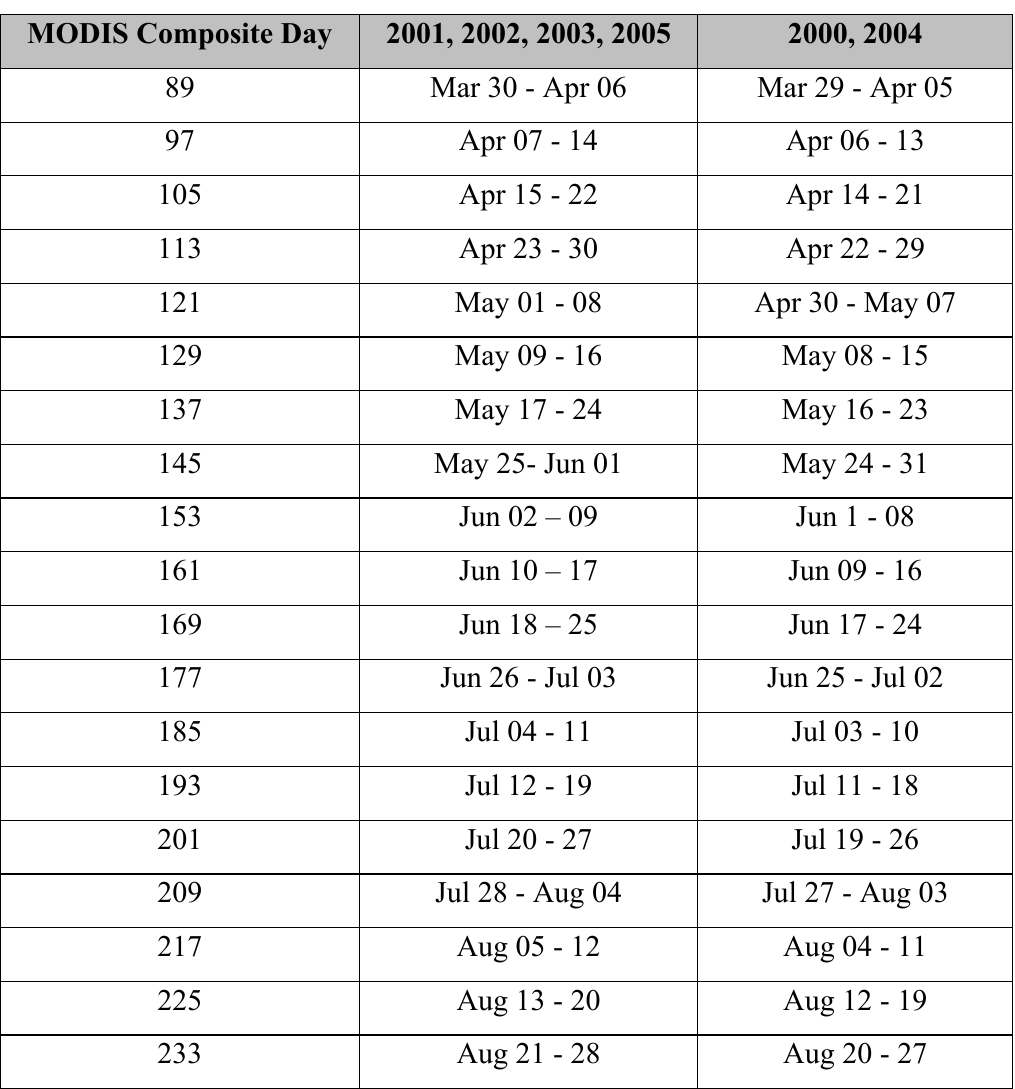
Table 2. MODIS composite day and corresponding calendar